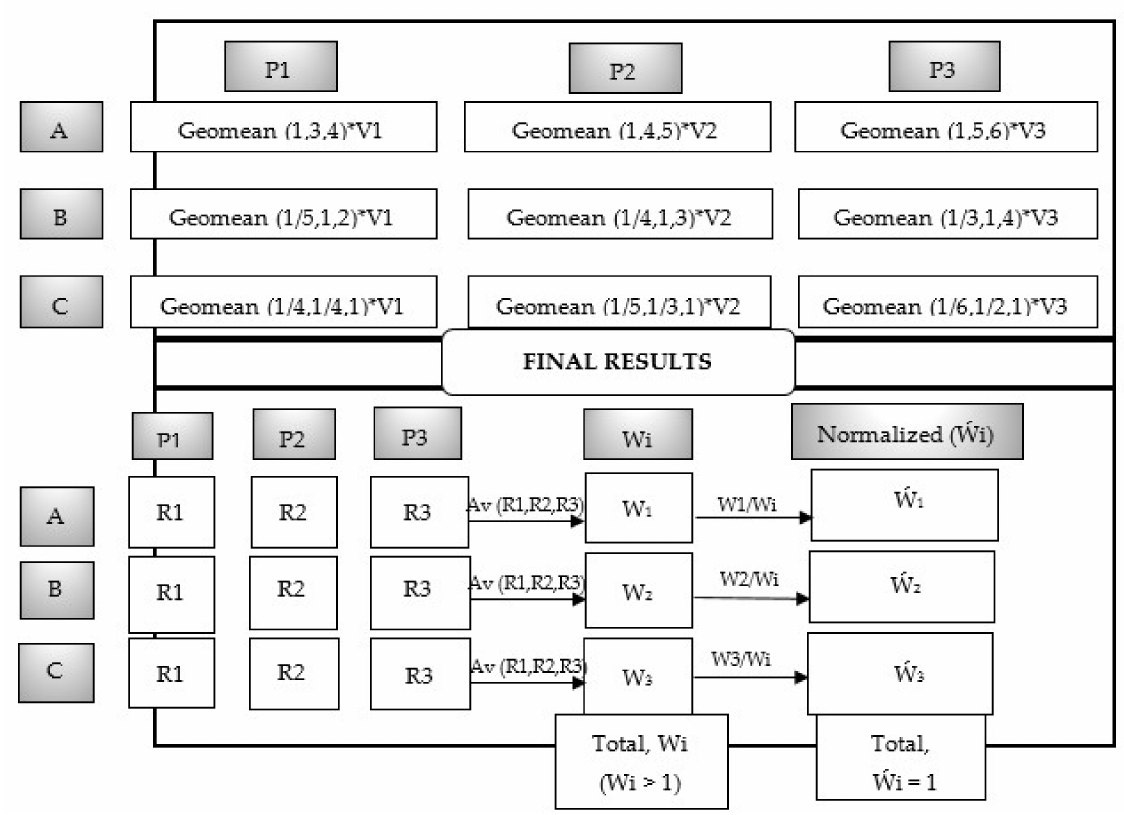
Figure A3. Computation of final weights in fuzzy AHP model.